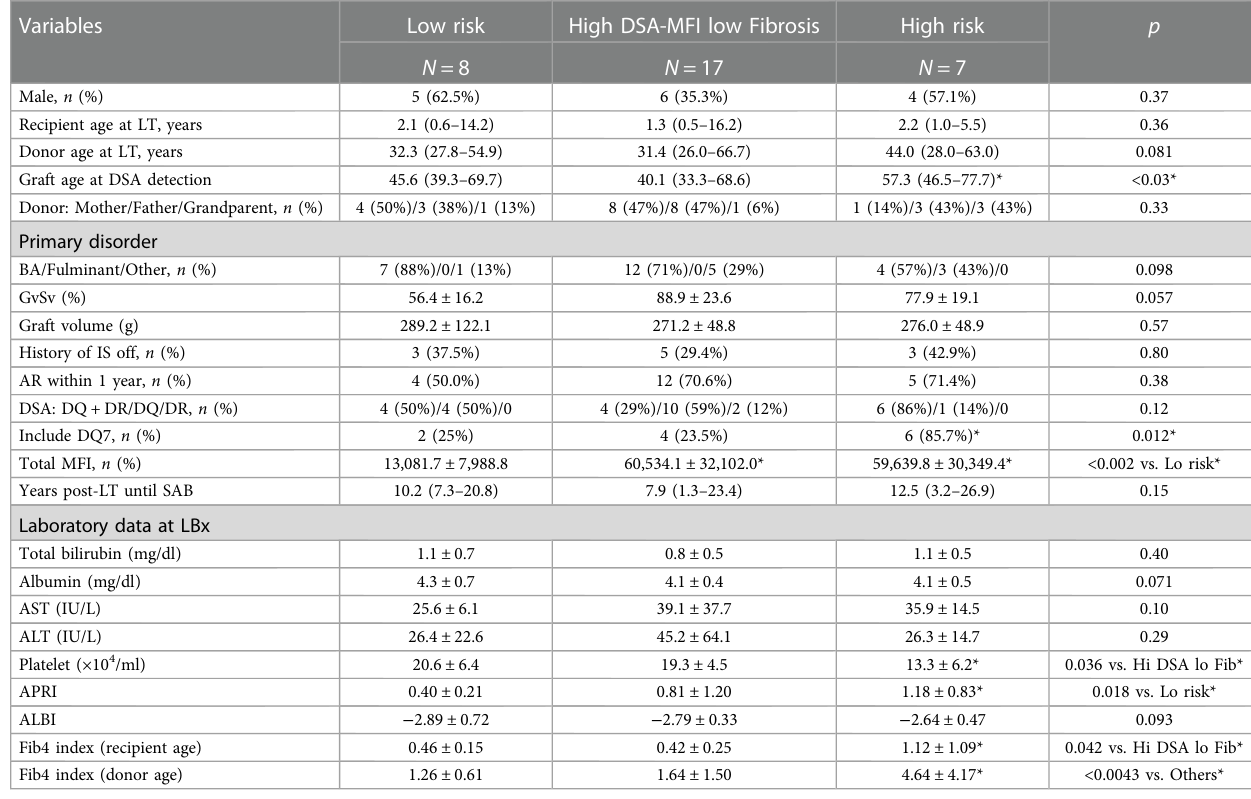
TABLE 2 Risk factors for graft fi brosis progression in the presence of post-LT DSA.